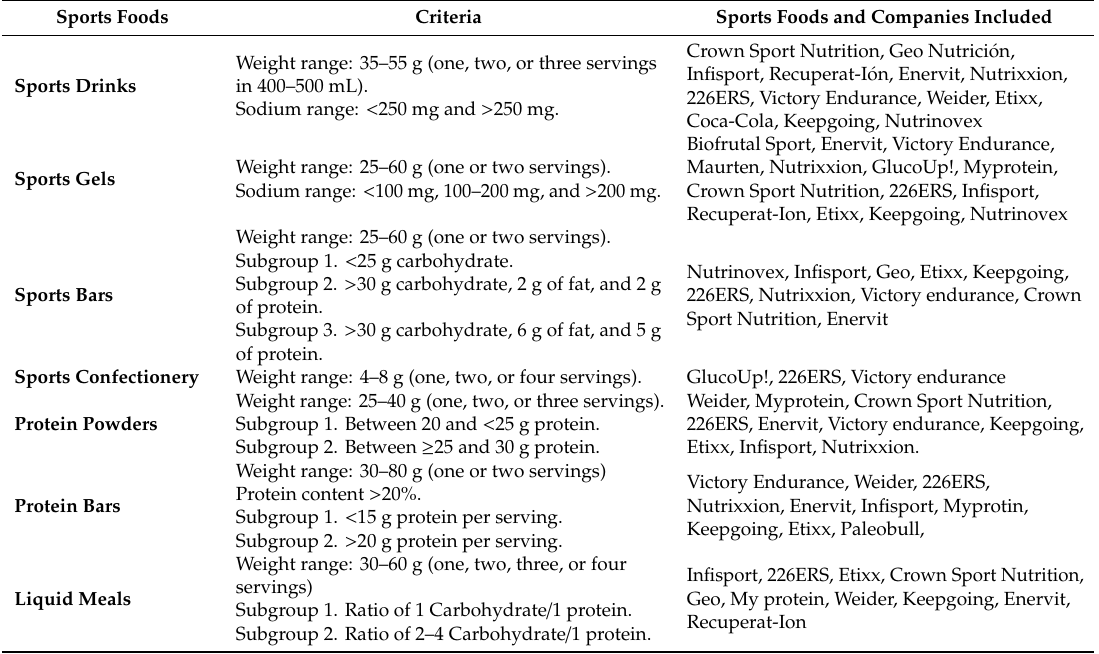
Table 1. Groups and subgroups of sport foods included, and criteria to select the net weight of the portions tested to define the sports foods